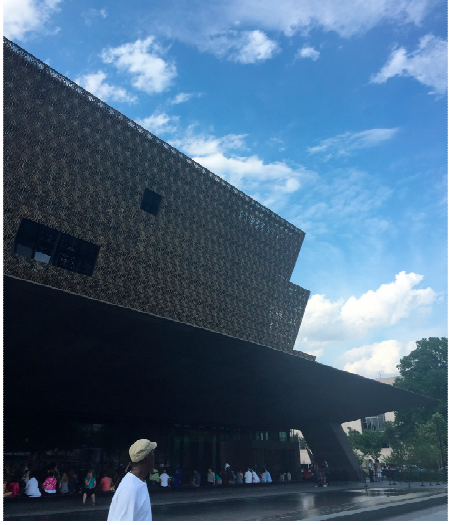
Figure 3. The bronze colored exterior panels appear to change color as the sunlight changes, June 2017.